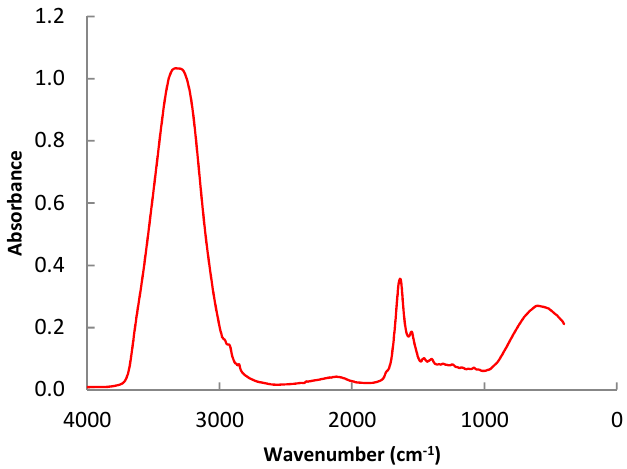
Figure 2. Representative spectrum of the samples analyzed.